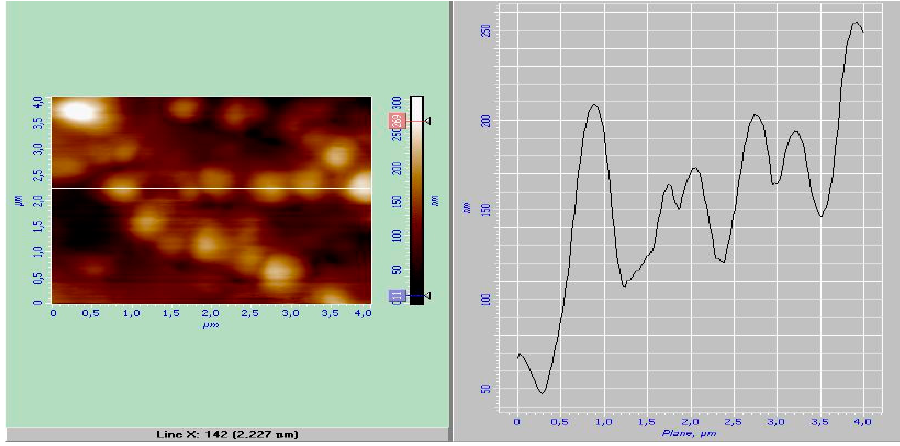
Figure 13. AFM data for the sample of the hybrid metal–mesogenic nanosystem Ag/4-cyano-4 ′ -pentylbiphenyl (1:10 w/w%) encapsulated in poly-para-xylylene film.